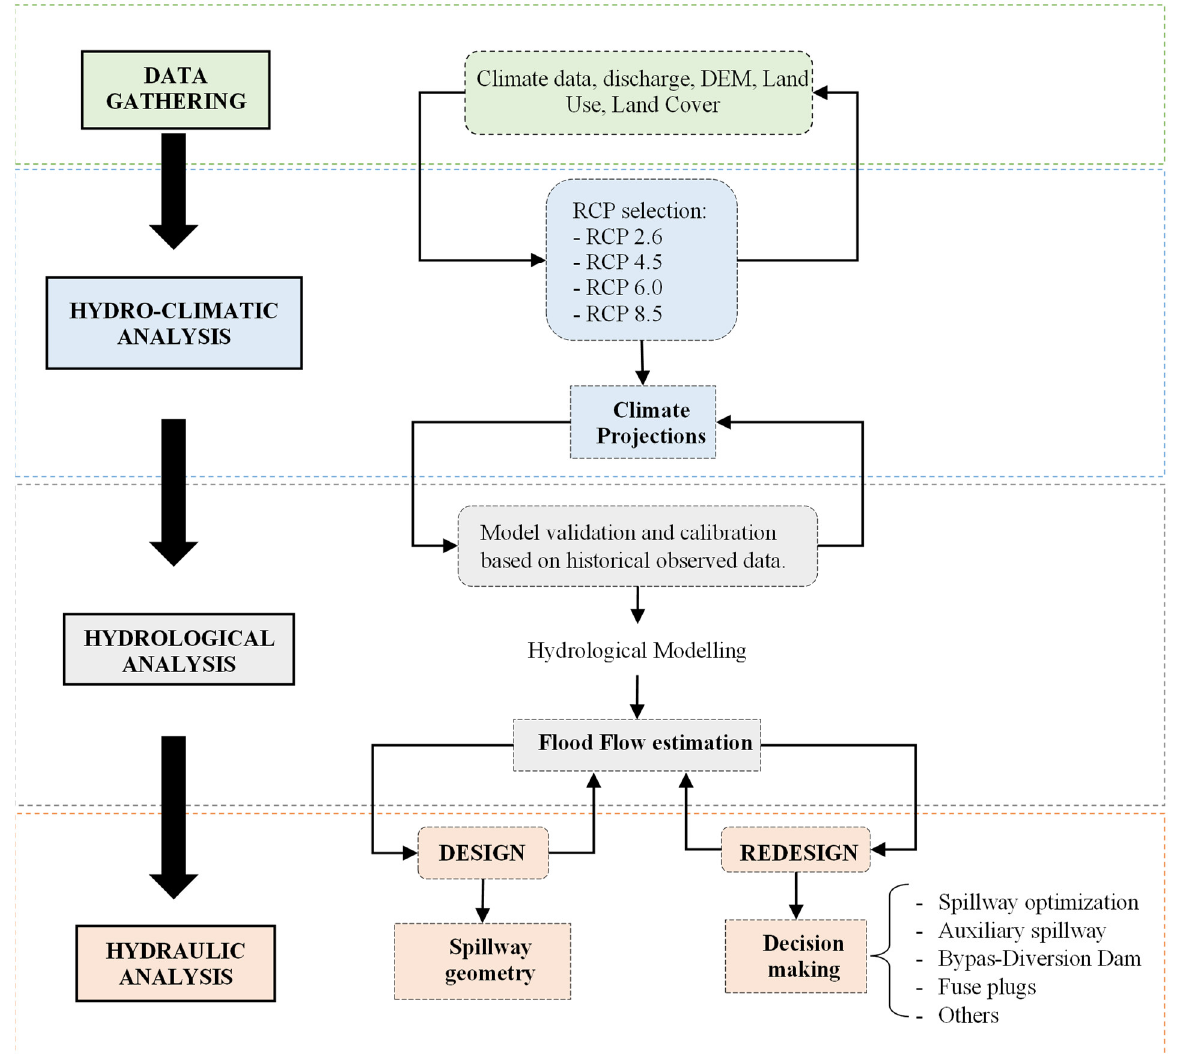
Figure 3. Methodology of spillway design including CC considerations.